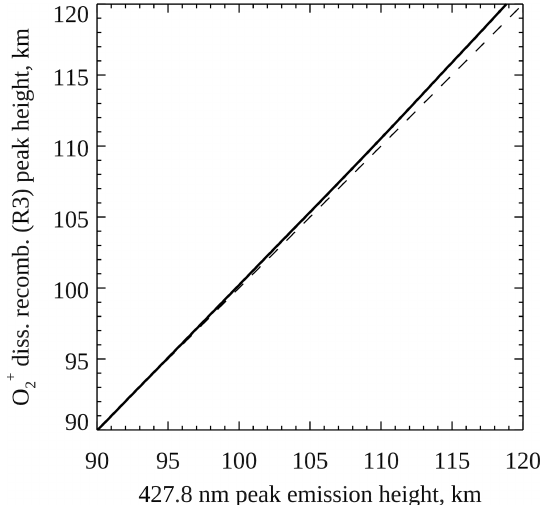
Figure 12. Modelled peak height of the production rate of O( 1 S ) by dissociative recombination of O + (Reaction R3) against the blue 2 427.8nm peak emission height (electron impact ionisation of N 2 ). The dashed line marks where the two rates would be